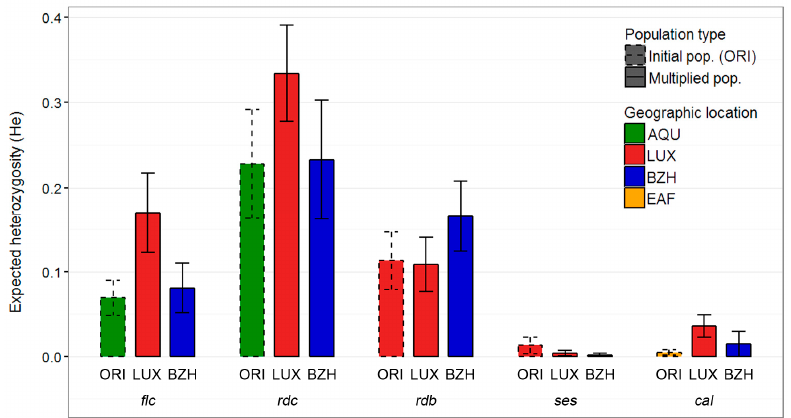
Figure 2. Expected heterozygosity ( He ) of three experimental populations of five common bean varieties, respectively. Colors of bars indicate the geographic location where seed lots were grown.